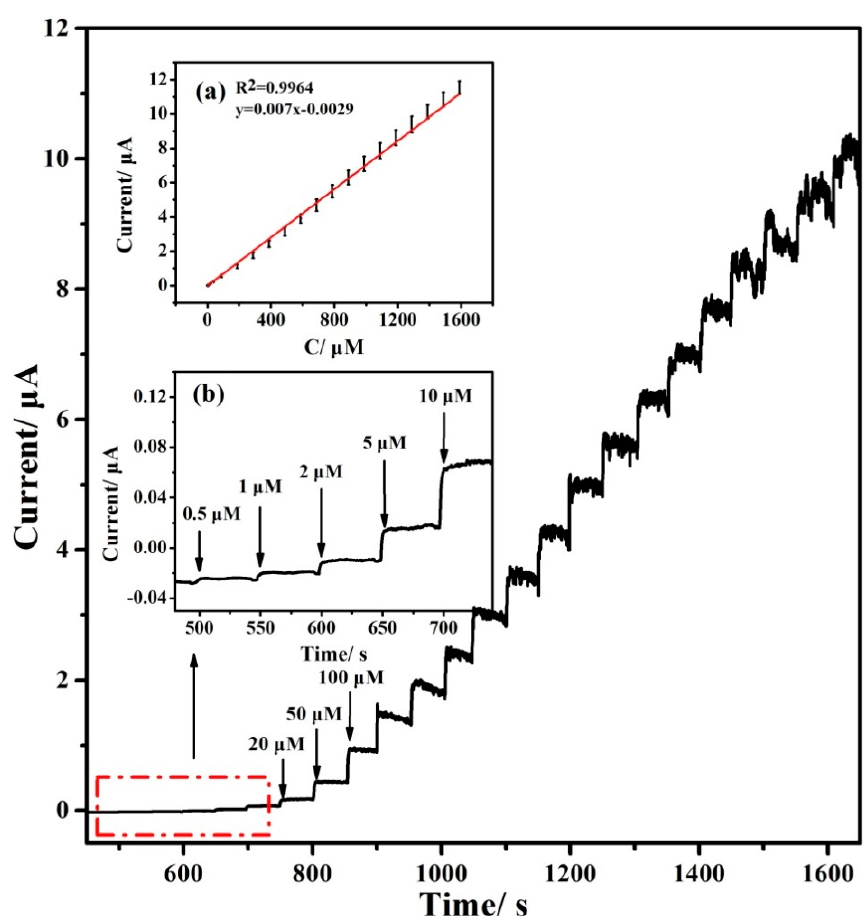
Figure 5. Amperometric responses of the Pd 2+ /COFs/GCE to successive additions of various concentrations of hydrazine in 0.1 M NaOH at − 0.1 V. (Inset: ( a ) the corresponding calibration plot, ( b ) the amplified response curve.).